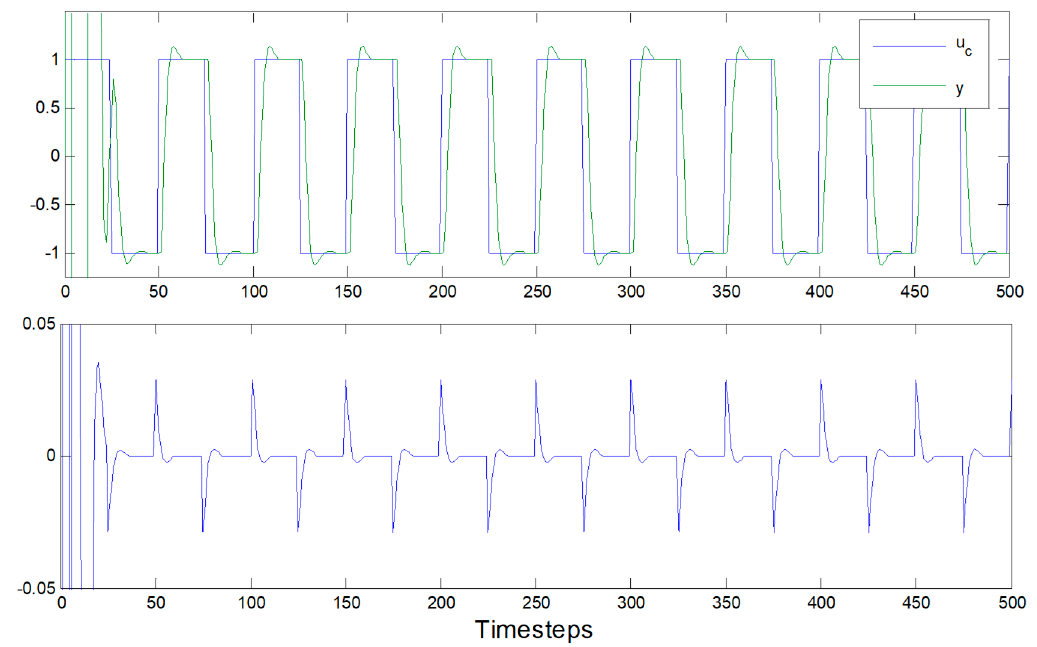
Figure 7. Control u ( t ) output y ( t ) versus time: time-step propagation extended to 500 to reveal consistent performance following startup transient.